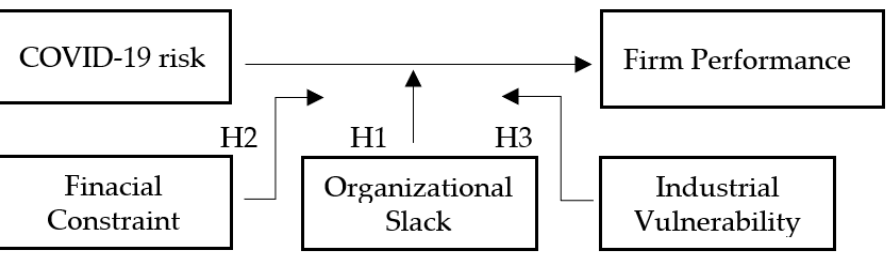
Figure 1. Conceptual structure.